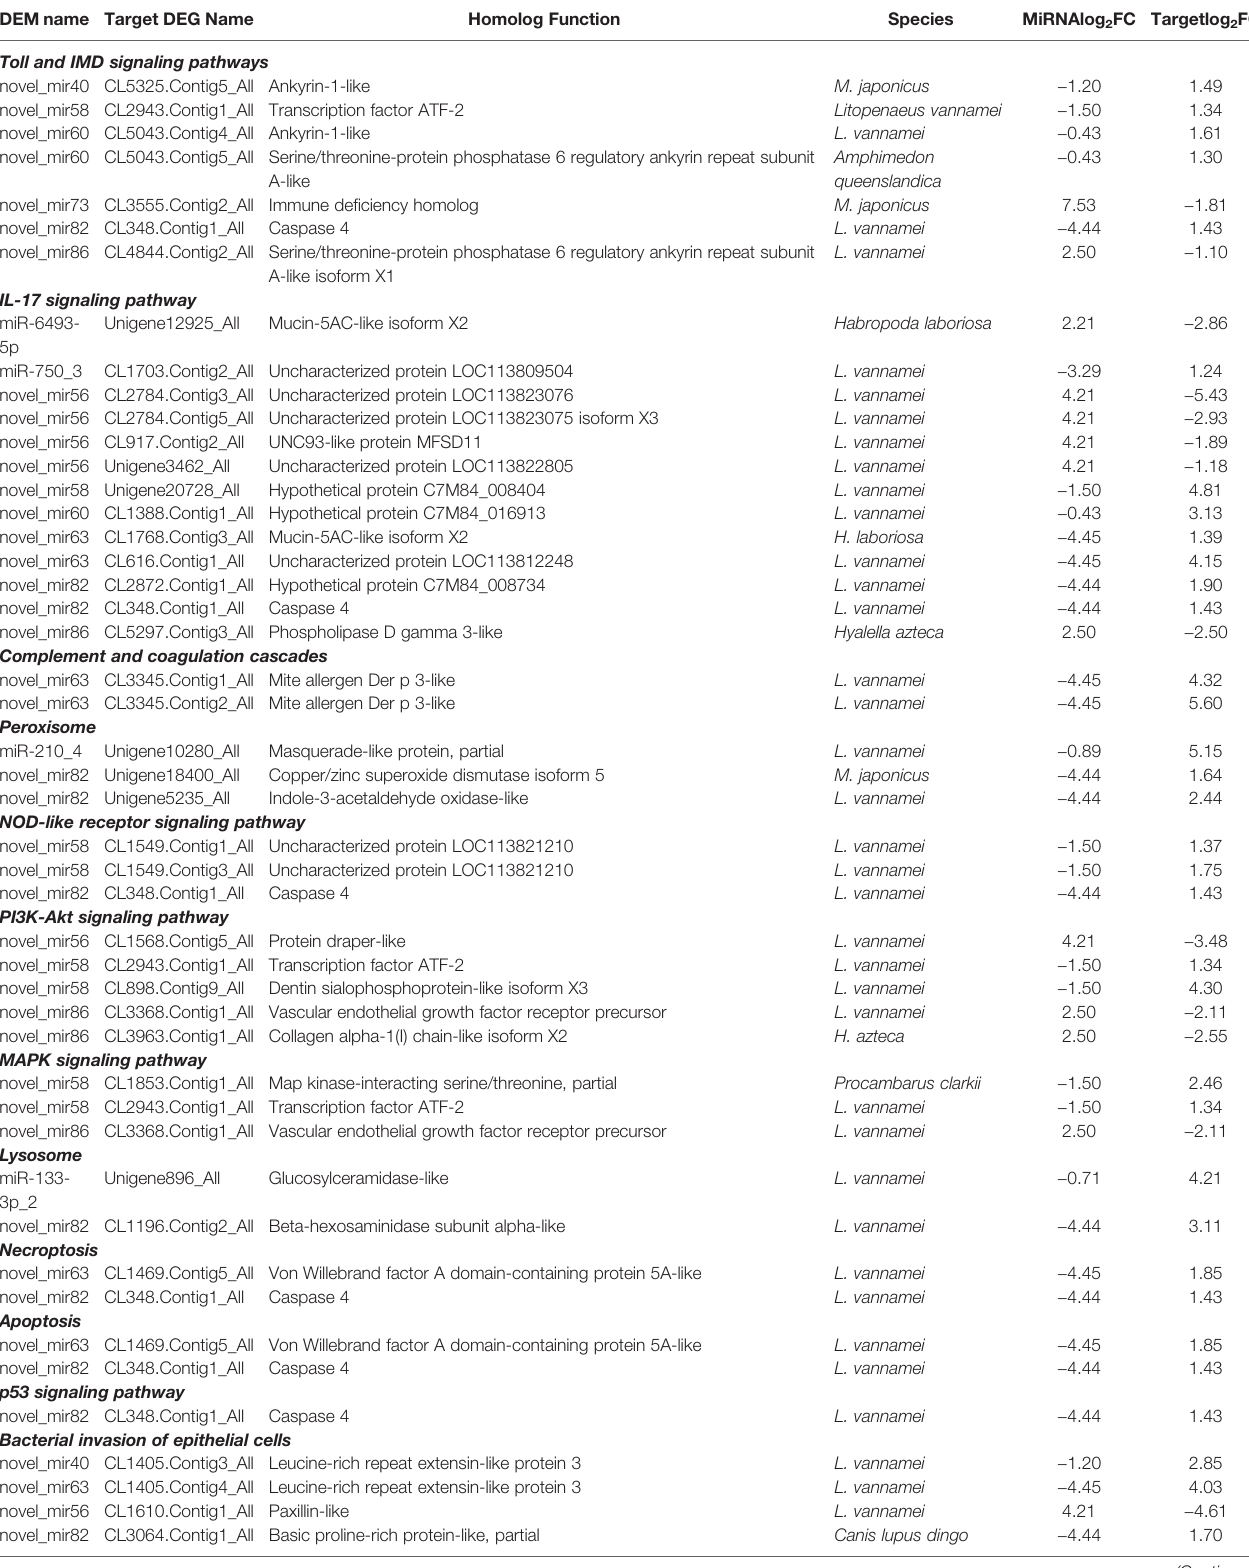
TABLE 5 | Candidate miRNA – mRNA pairs involved in Marsupenaeus japonicus intestinal immune response against